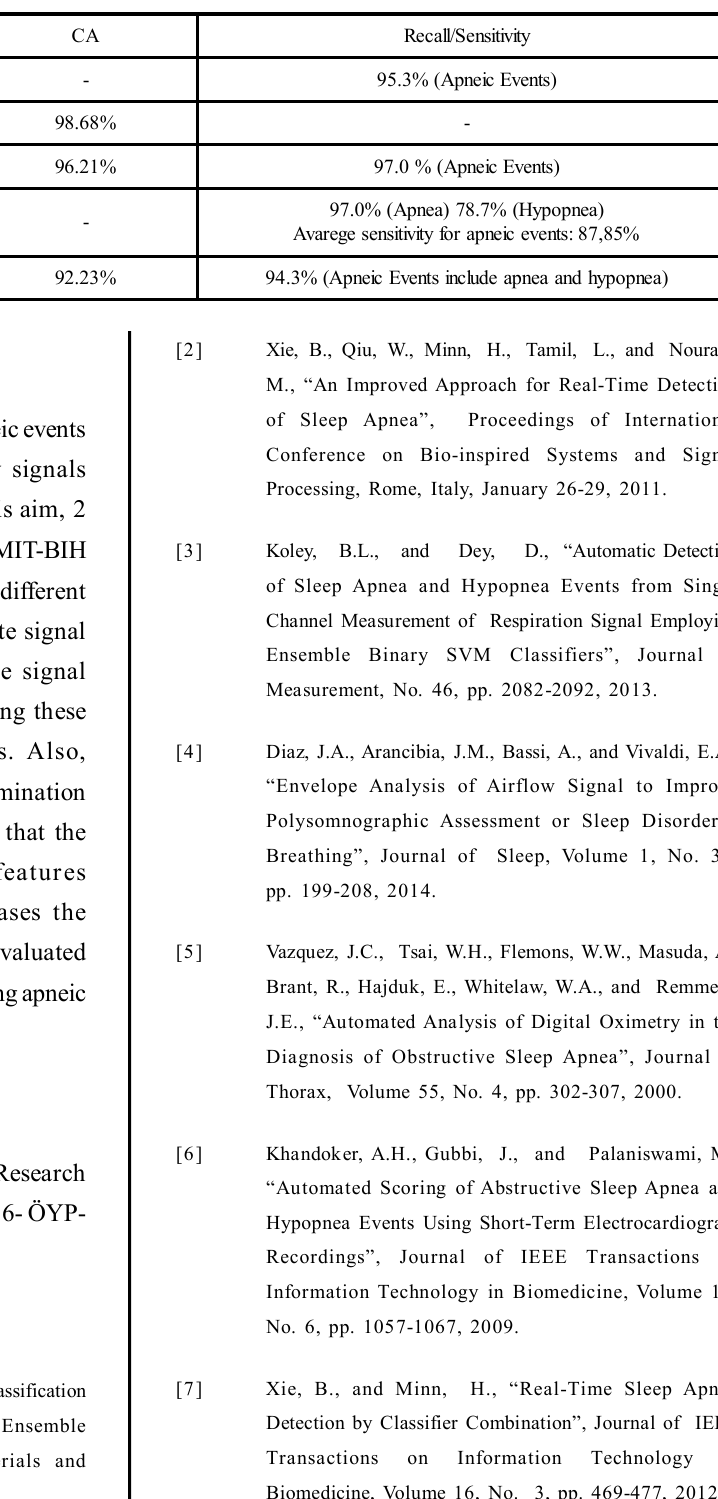
TABLE 8. COMPARISION OF THIS STUDY AND LITERATURE